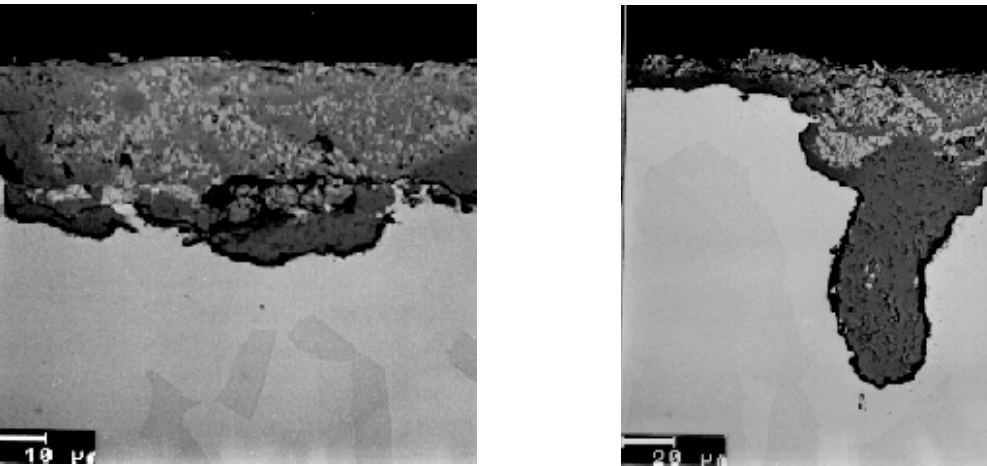
Figure 3. Cross-sectional morphologies of NiAl-30Fe alloy after oxidation at 1100 °C for 490